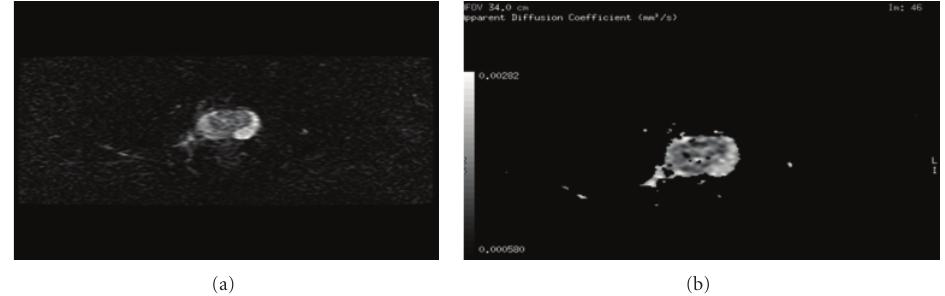
Figure 3: Example of 62-years-old male patient with cancer prostate and PSA > 10ng/mL. At the corresponding DWI/ADC map (a) there is a relative hyperintense lesion at the medial aspect of the right PZ at b = 800 and it is hypointense at b = 0 and at ADC map (b).